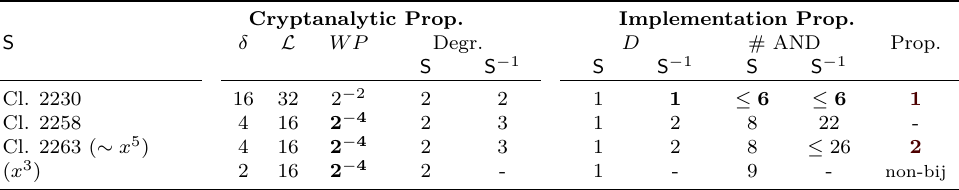
Table 5: Minimal-depth 6-bit S-boxes Overview